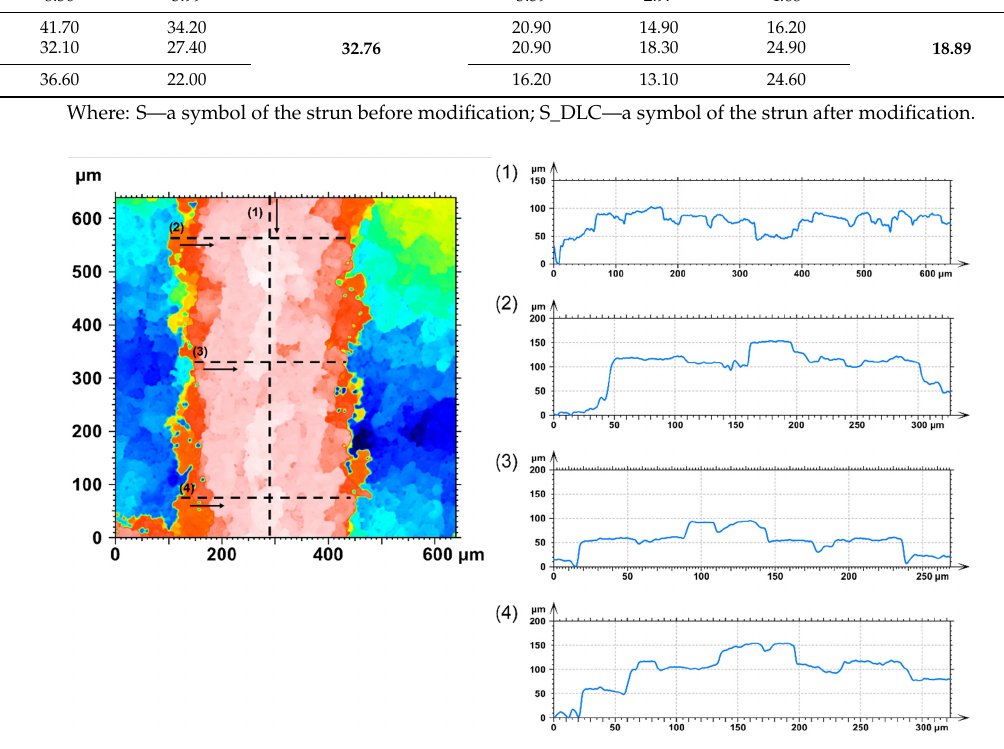
Figure 12. The surface topography image obtained for one of the strun of Voronoi structure before modification with DLC coating and roughness profiles (black arrows indicate the direction in which to draw the profile).